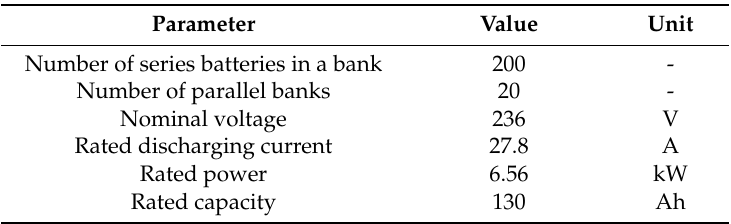
Table 3. Parameters of Lithium-Ion